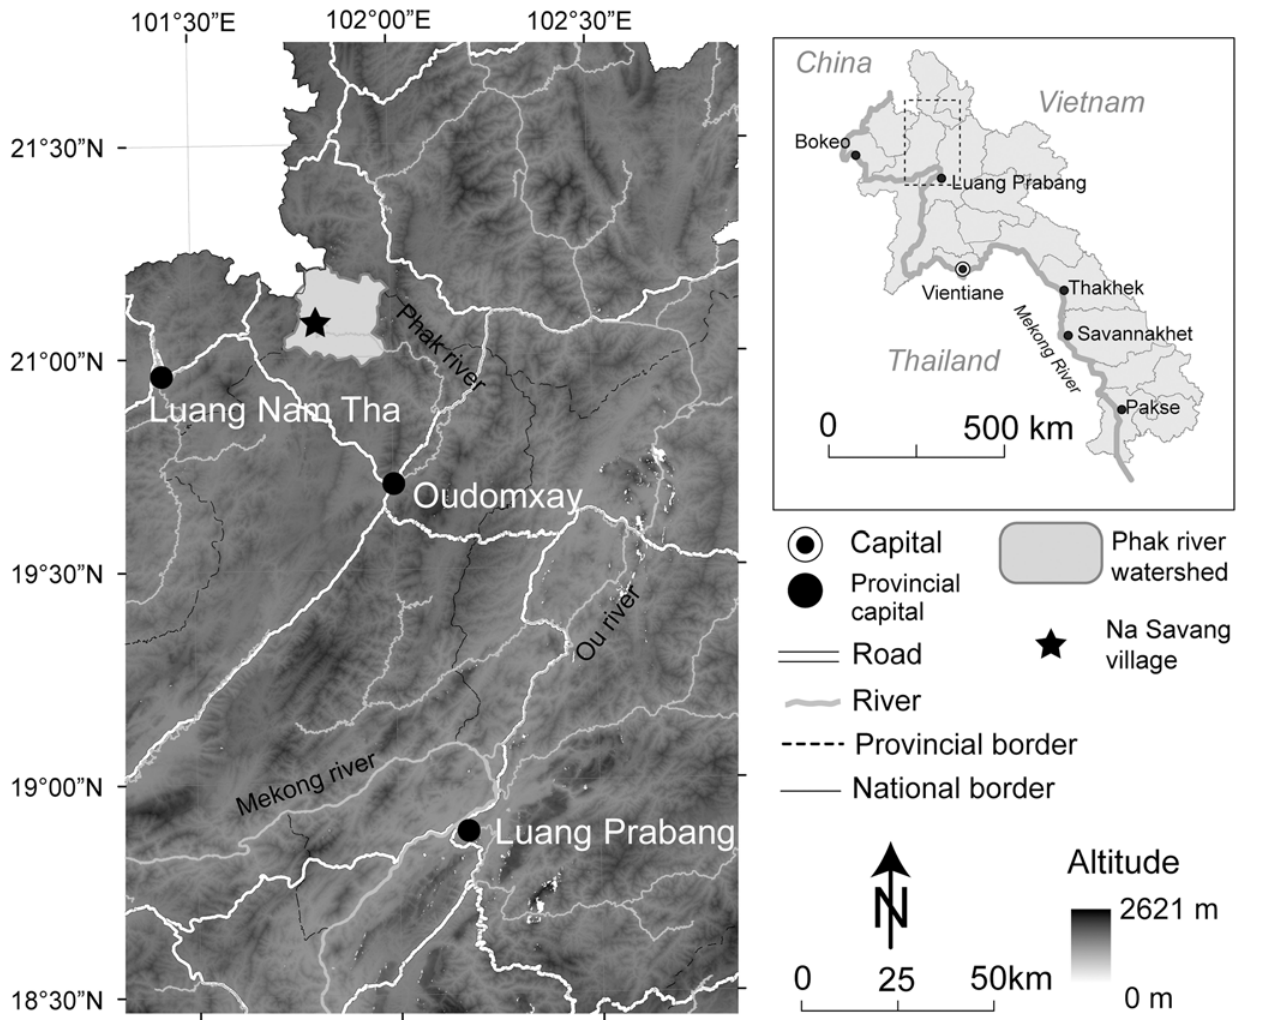
Fig 2. Location of the study site, Na Savang village, Oudomxay Province, northern Lao